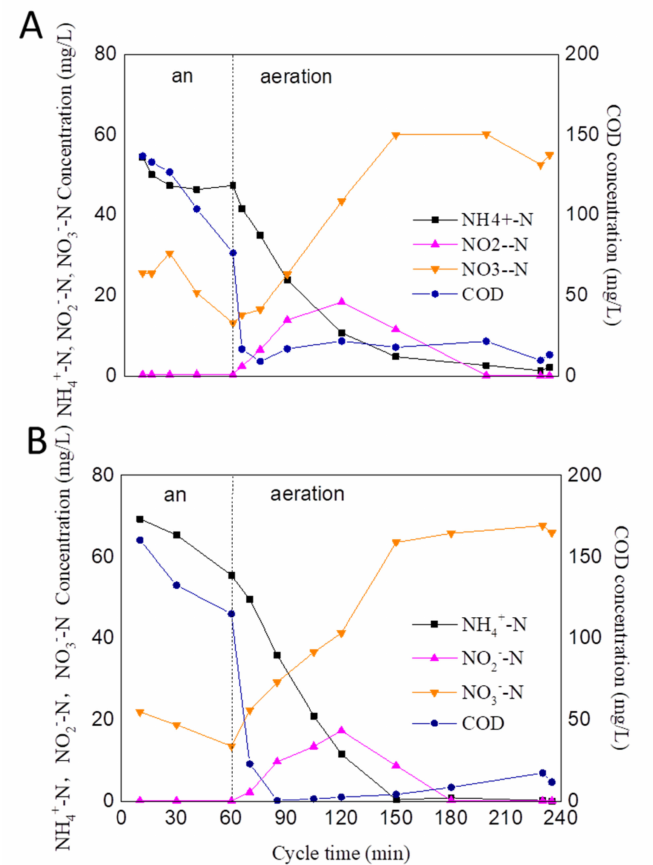
Figure 4. Profiles of NH 4+ -N, NO 2 − -N, and NO 3 − -N concentrations in batch cycles: ( A ) On day 92 with MLSS of 2.1 g/L; ( B ) on day 237 with MLSS of 4.0 g/L.